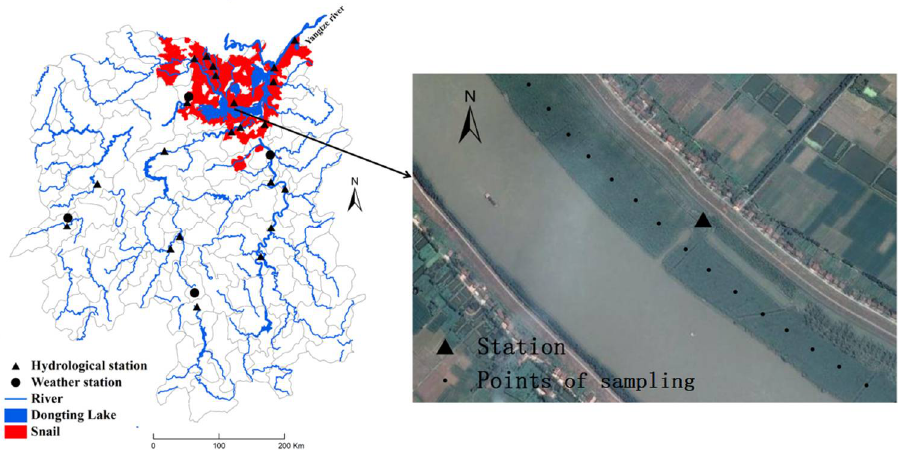
Figure 2. Systematic sampling of points along the marshland.